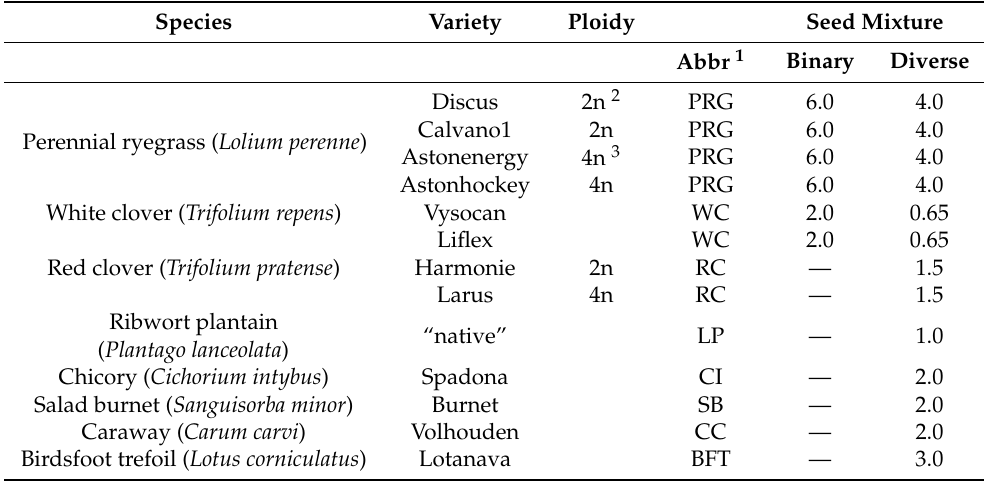
Table 2. Composition and sowing rate (kg ha − 1 ) of the binary and diverse seed mixtures used in the